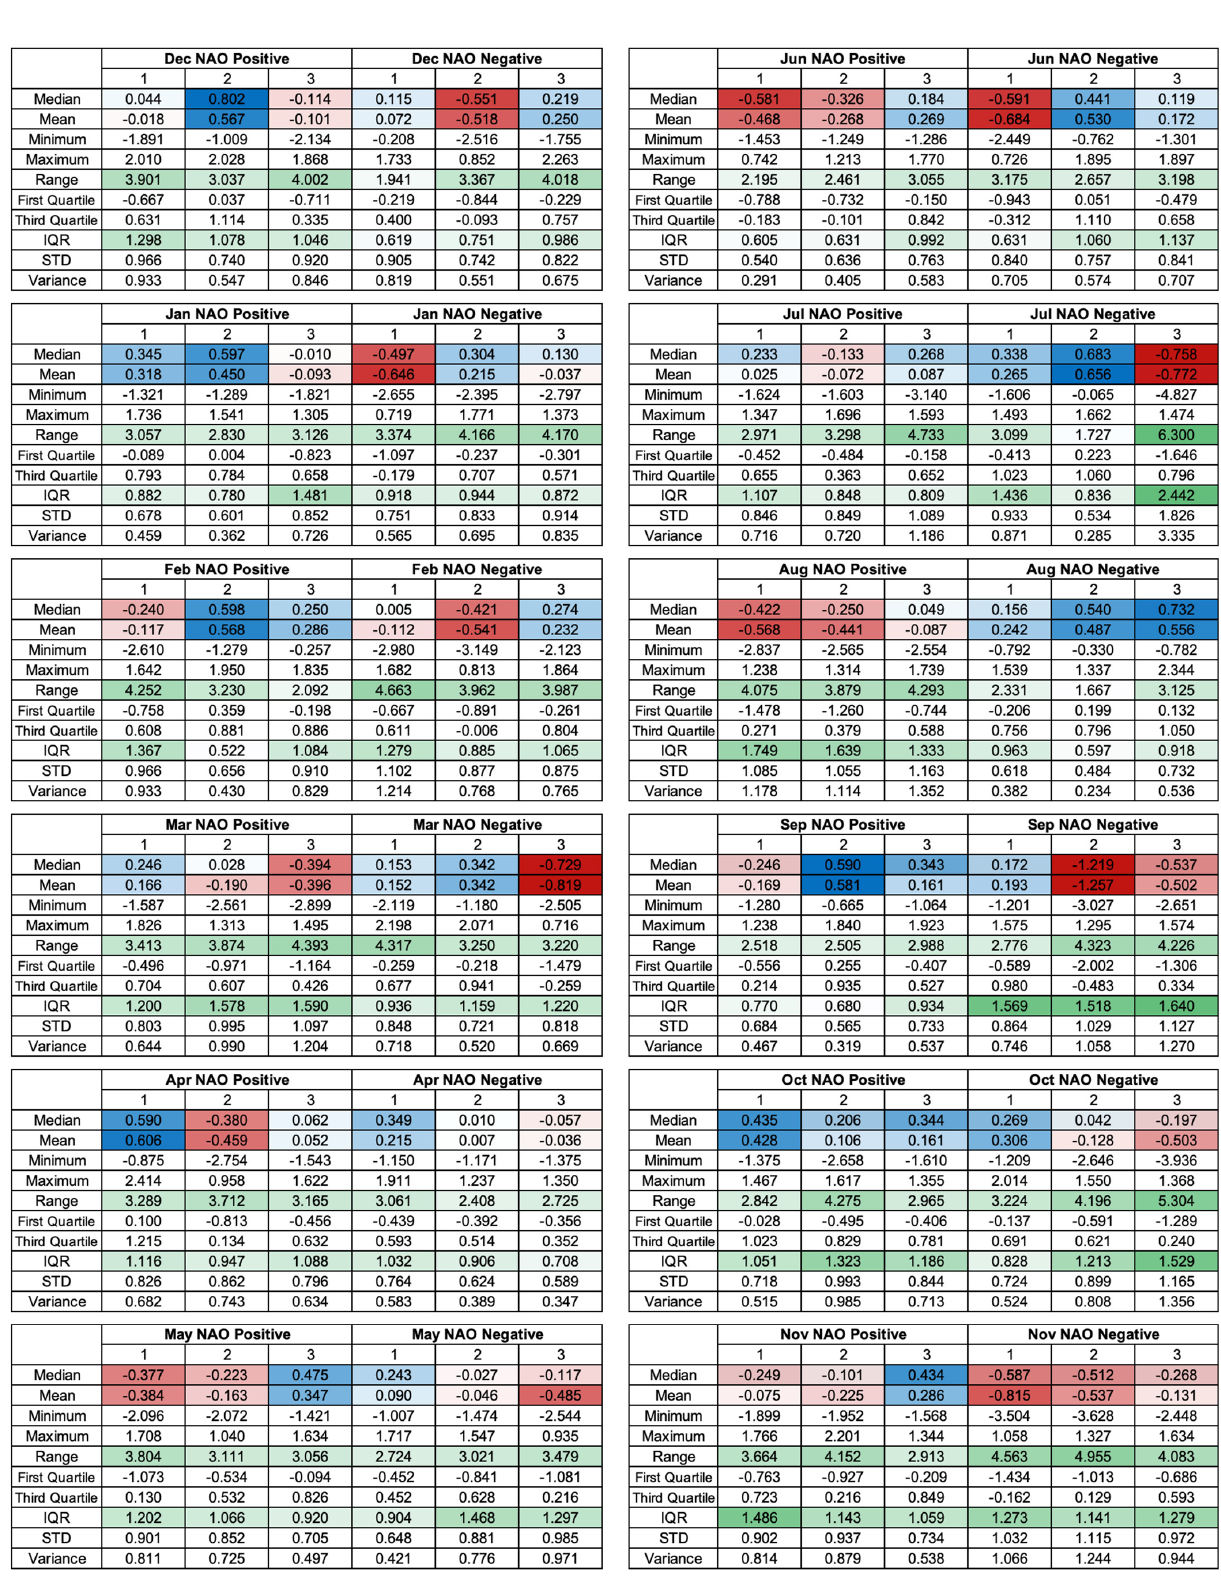
Figure 10. Descriptive statistics for the space-time cluster median SPI-1 box plots in Figure 9 (IQR = interquartile range; STD = standard deviation). Formatting of colours is applied per statistical measure. Blue indicates wetter mean/median SPI-1 values, red indicates drier mean/median SPI-1 values. Green graduated shading indicates greater range/IQR values.